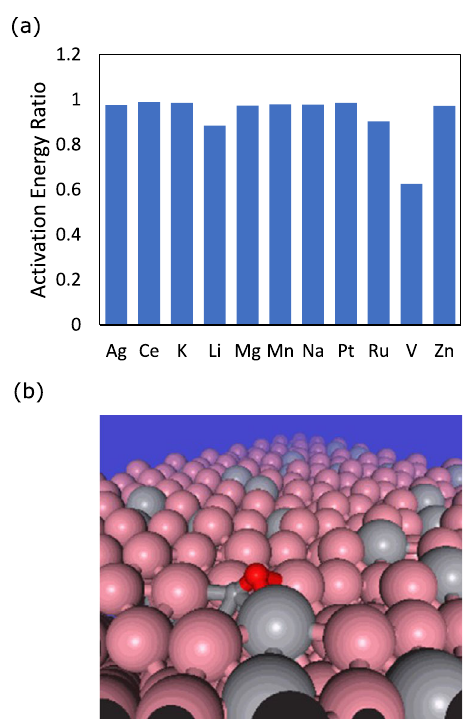
-- 21) surface. a Normalized